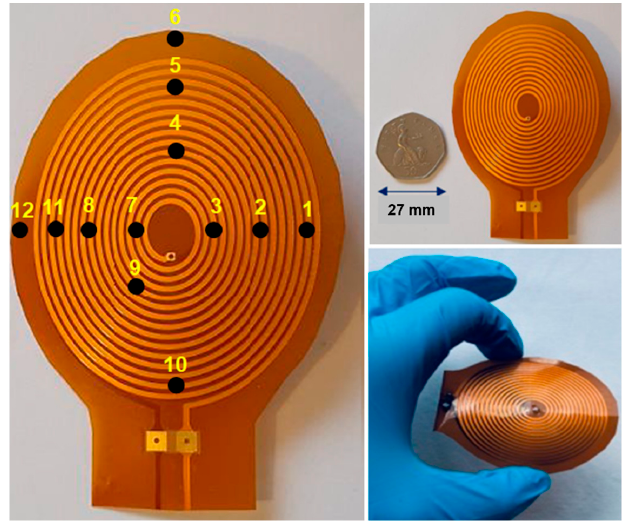
Figure 3. An illustration of thin and flexible coils with the position of the twelve NTC thermistors (numbered 1 to 12) adhered on the coil surface.